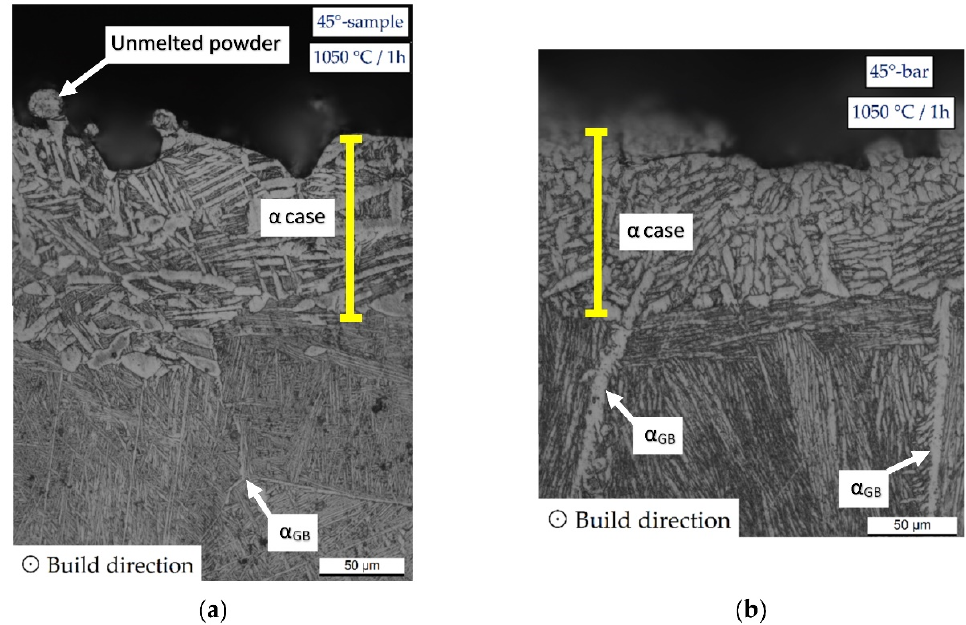
Figure 7. OM micrograph of the cross-section of the 45°-sample ( a ) and 45°-bar ( b ) after heat treatment at 1050 °C/60 ′ .